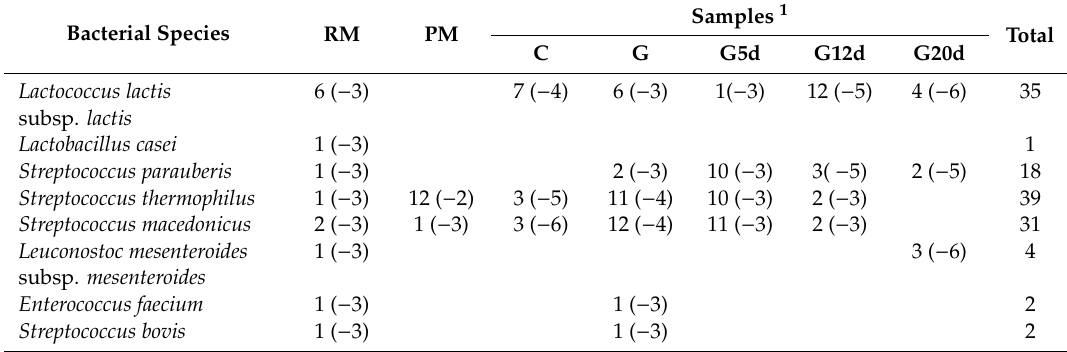
Table 1. Occurrence of di ff erent species of lactic acid bacteria during cheese-making of Giuncata leccese cheese. Number of isolates from each sample with isolation dilution is reported in parentheses.